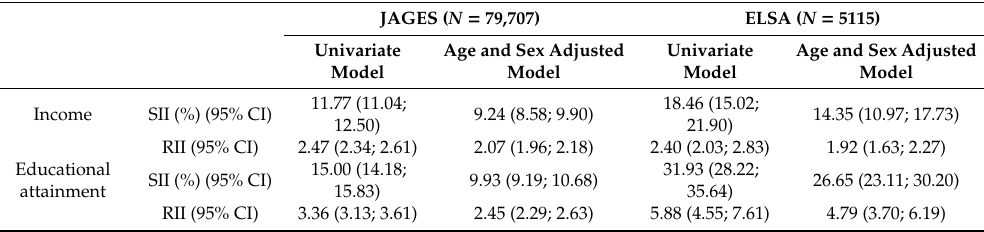
Table 2. Absolute and relative socioeconomic inequalities of edentulousness in JAGES and